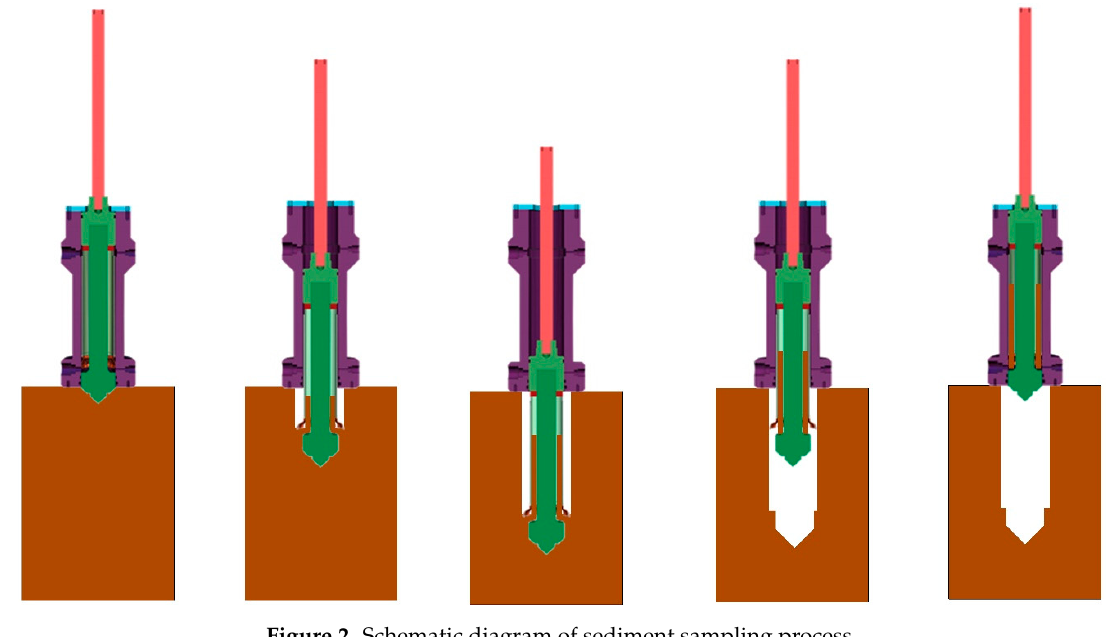
Figure 2. Schematic diagram of sediment sampling process.